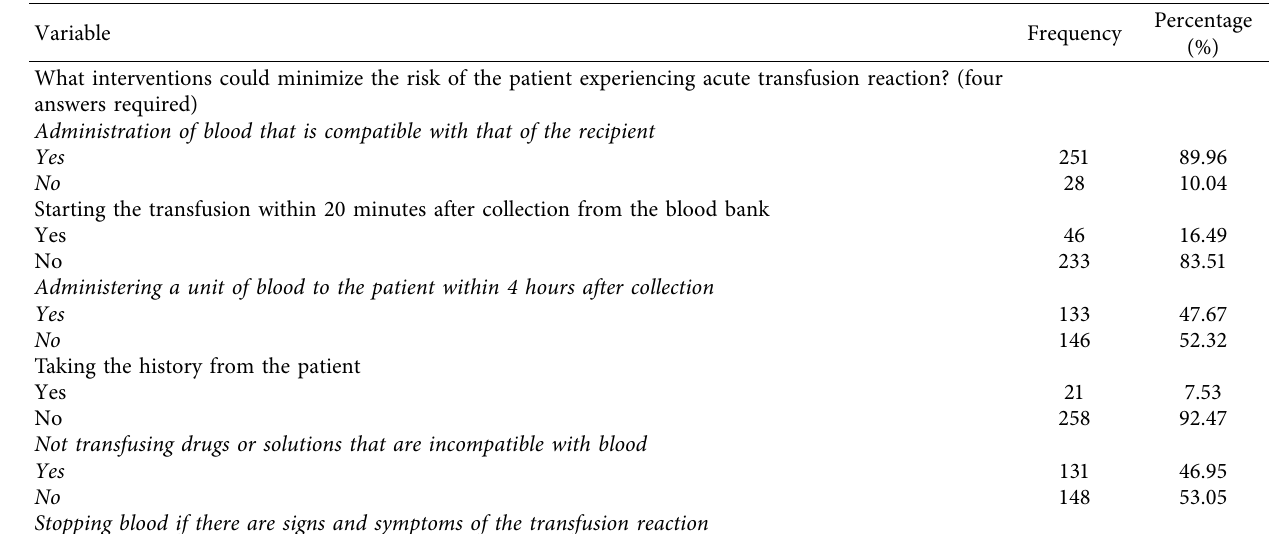
Table 8: Complications related to blood